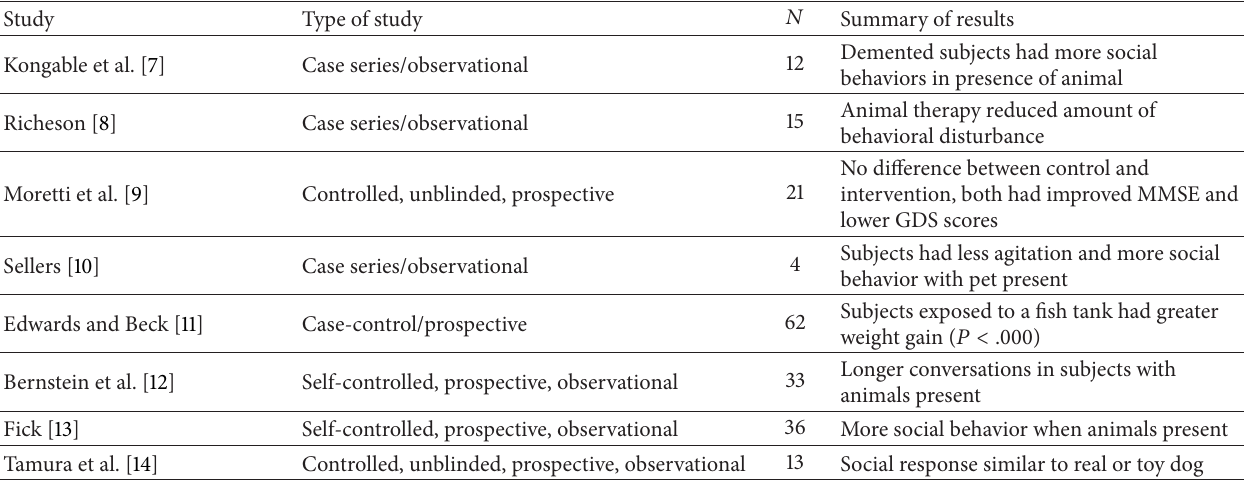
Table 1: Studies on use of animals in